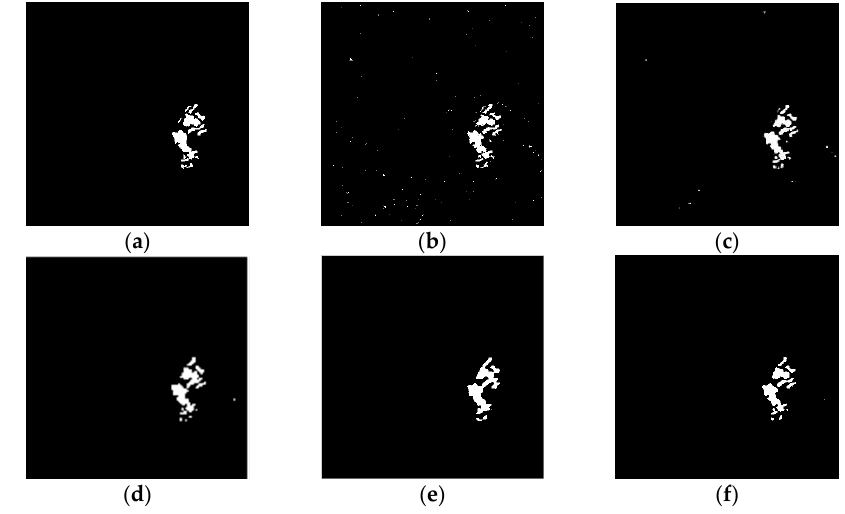
Figure 5. Change detection images obtained for the Bern data set: ( a ) The reference change image; ( b ) NSCT-FCM; ( c ) MRF-FCM; ( d ) PA-GT; ( e ) PCA-NLM; ( f ) Proposed algorithm.